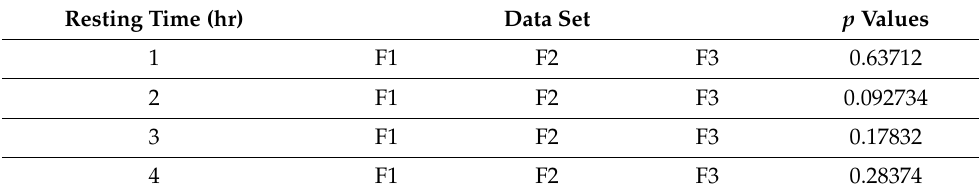
Table 3. Statistical analysis of biogas production at various resting times during mixing. Resting Time (hr) Data